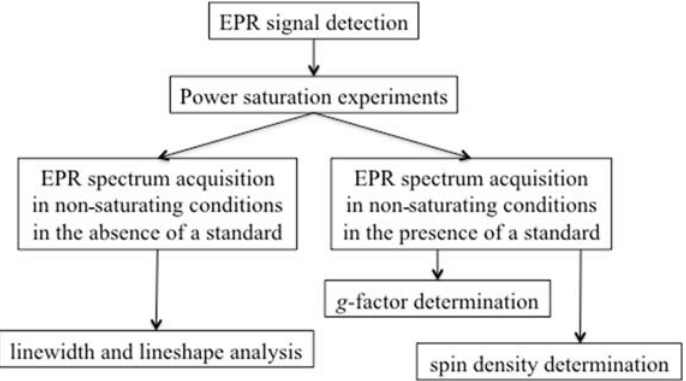
Figure 2. Flowchart of the Electron Paramagnetic Resonance (EPR) test protocol. The preliminary power saturation experiments are necessary to determine the power of the incident microwave beam to be used in the following steps.